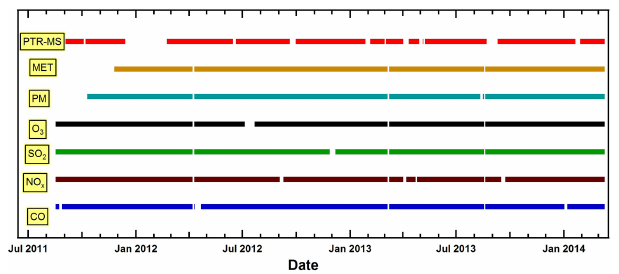
Figure 1. Status of analyzers and availability of data from the IISER Mohali ambient air quality